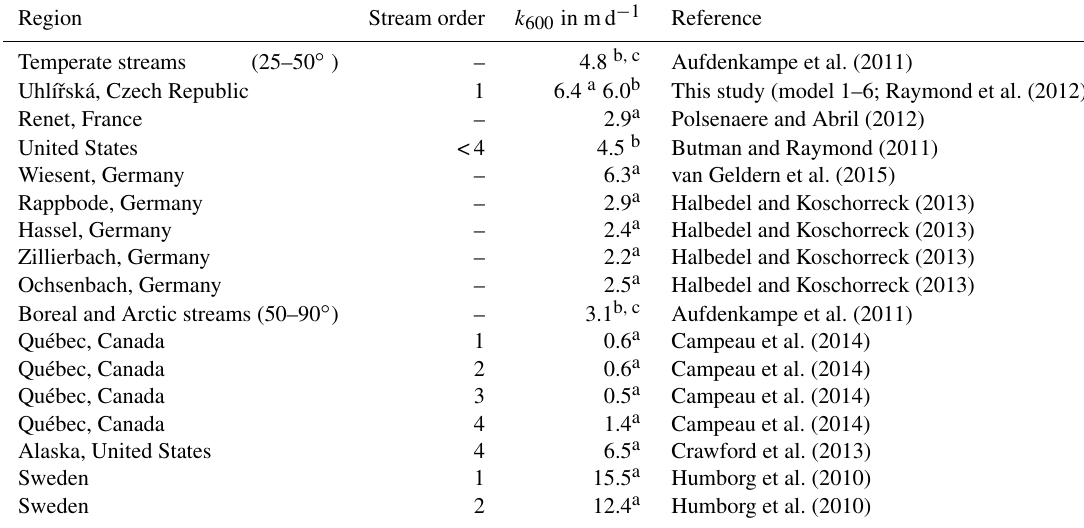
Table 4. Gas transfer velocities ( k 600 ) normalised to a stream temperature of 20 ◦ C of low order streams. Values calculated from model results are displayed in Table 3.